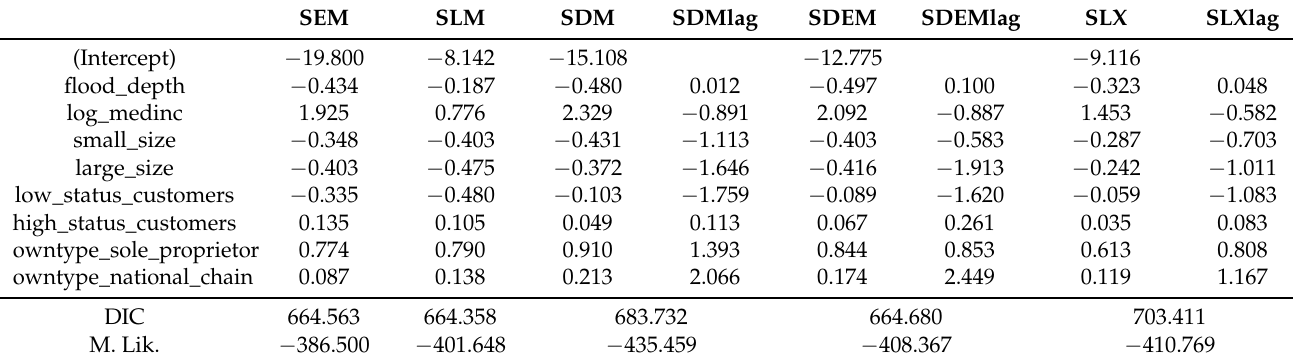
Table 2. Summary of point estimates of the fixed effects coefficients, Katrina business